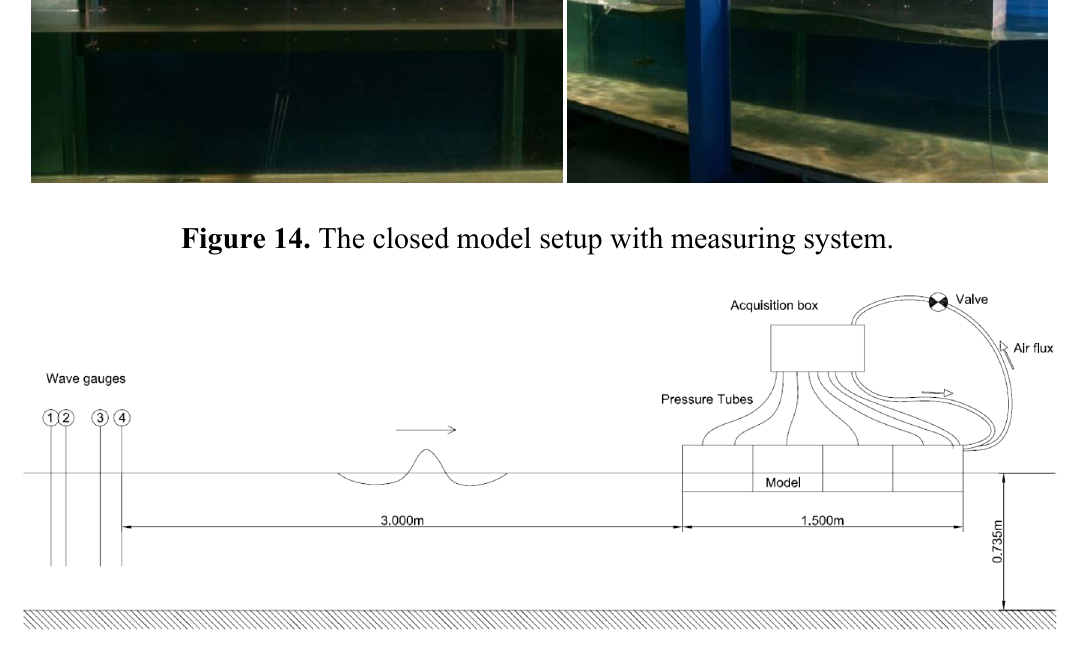
Figure 15. ( a ) Detail of the valves connecting each chamber to the low and high pressure ducts; and to ( b ) the external